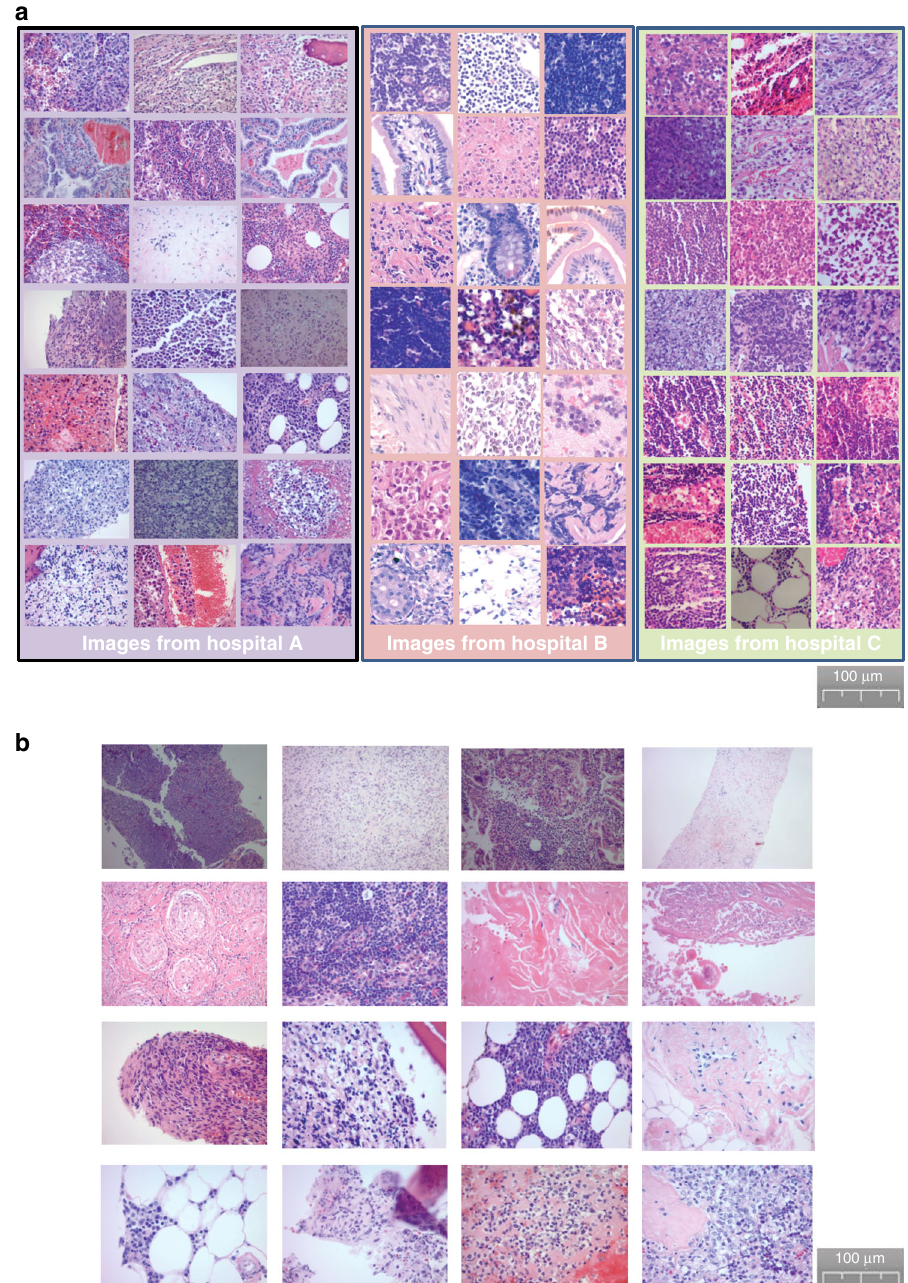
Fig. 2 Image variations derived from tissue preparation procedures. a There were some major variations in color, morphology, and quality of the slides, re fl ecting image variation derived from tissue preparation procedures. b There were some arti fi cial structures unrelated to human tissues in the slide images, including air bubbles, empty space,